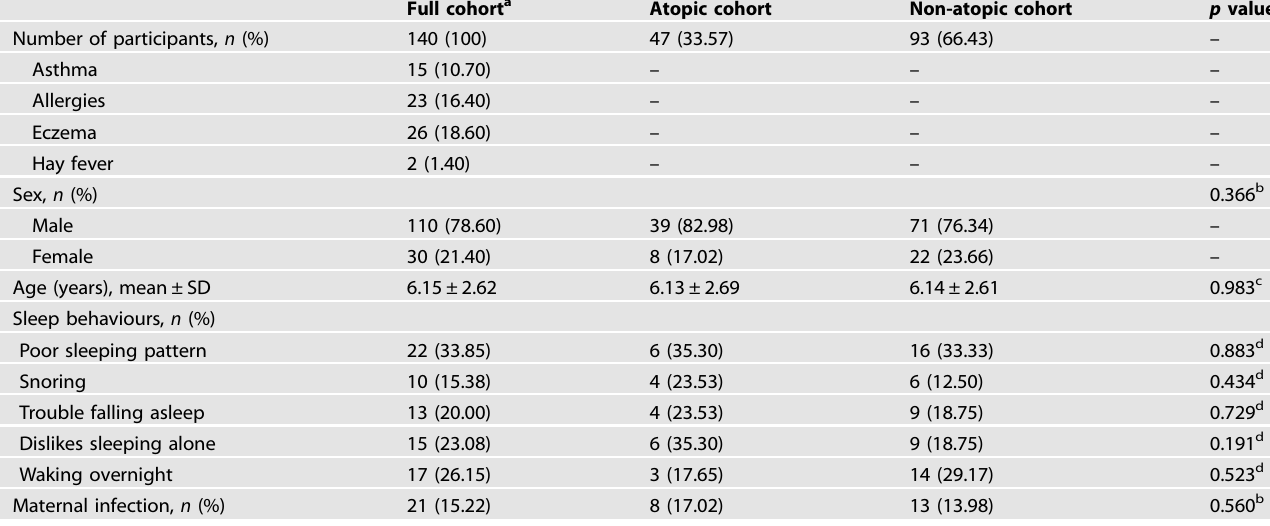
Table 1. Demographic characteristics of children with ASD in the atopic and non-atopic